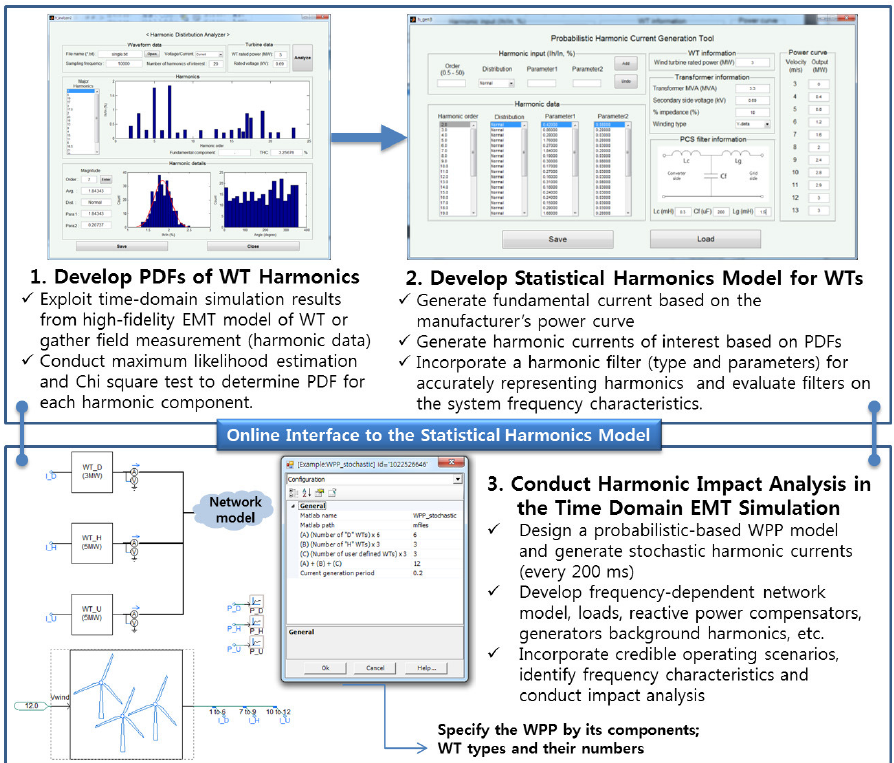
Figure 1. Proposed study framework and its implementation using MATLAB and PSCAD/EMTDC for assessing stochastic wind harmonics. PDFs: probability density functions; WT: wind turbine; EMT: electromagnetic transients; WPP: wind power